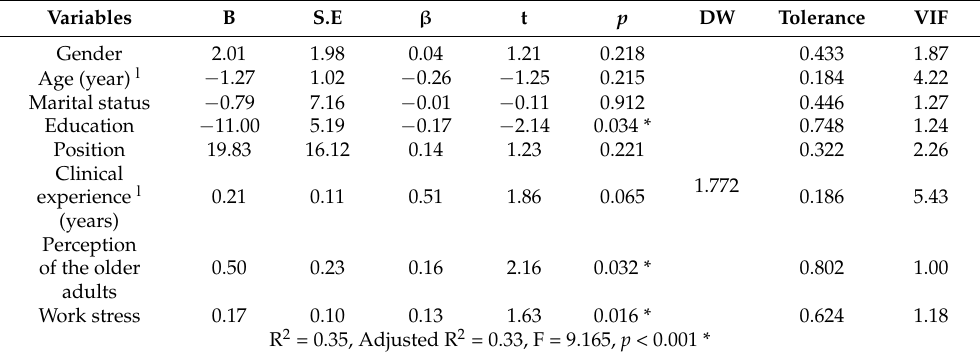
Table 3. Factors affecting nursing